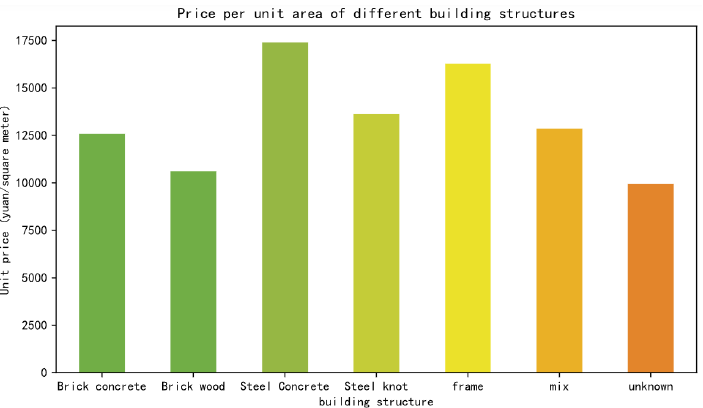
Fig. 9 House prices per unit area of various building